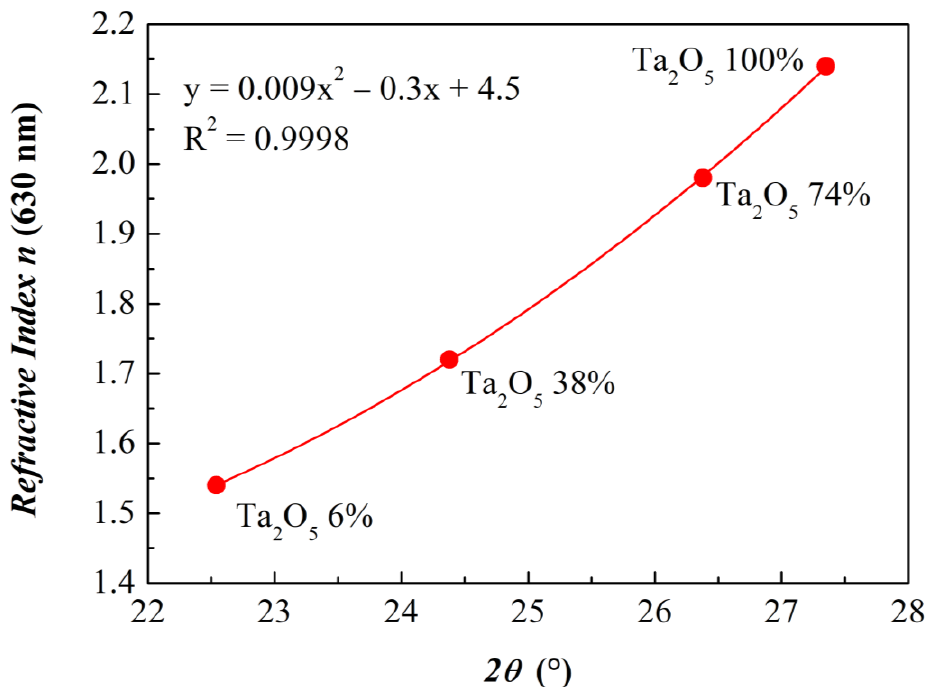
Figure 8. Trend of refractive indexes at 630 nm with respect to the first Gaussian maximum positions from the best fit to GIXRD series (shown in Figure 2a). Results are from acquisitions with Slit widths equal to 0.6 mm.